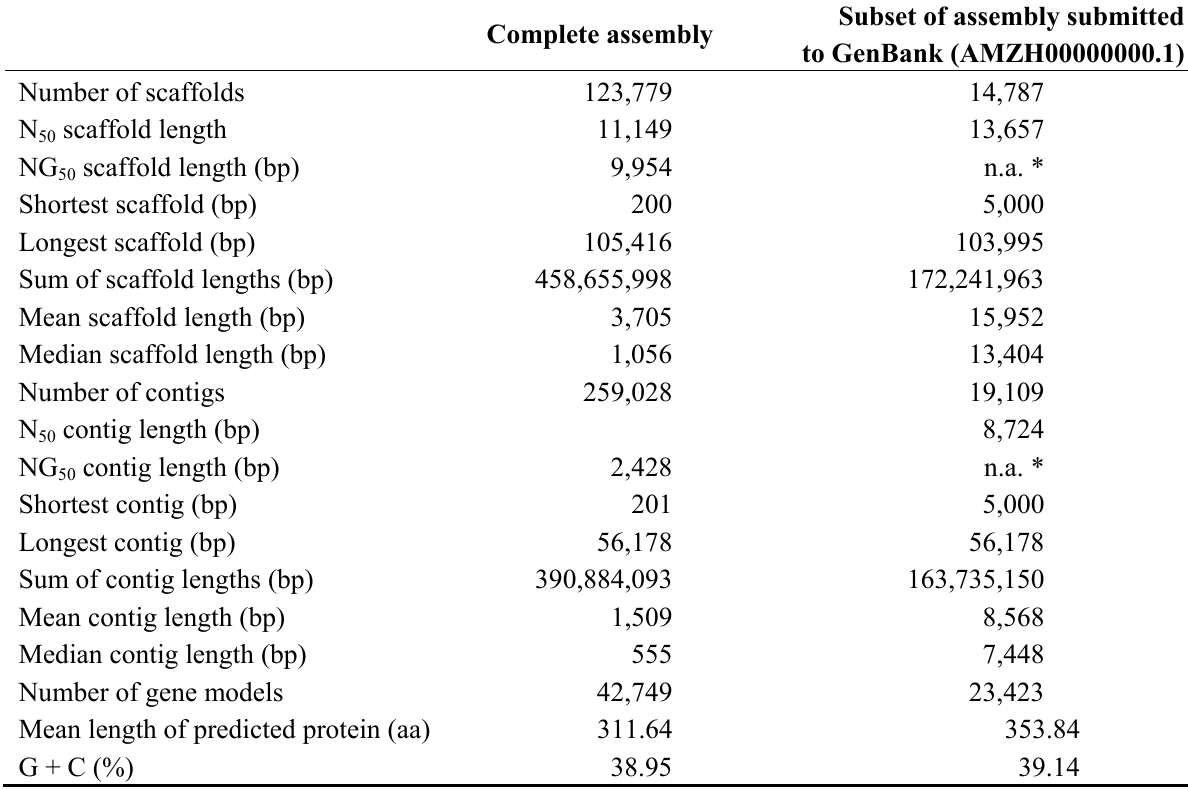
Table 2. Assembly statistics.